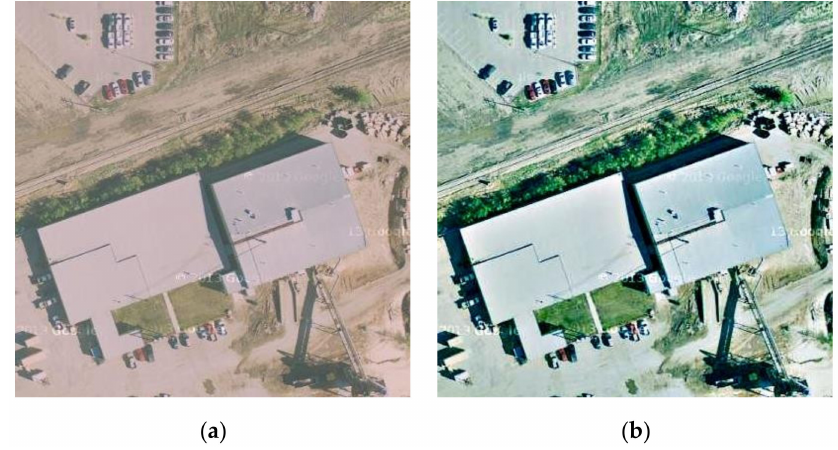
Figure 7. ( a ) Original image. ( b ) Improved image using MSRCR.